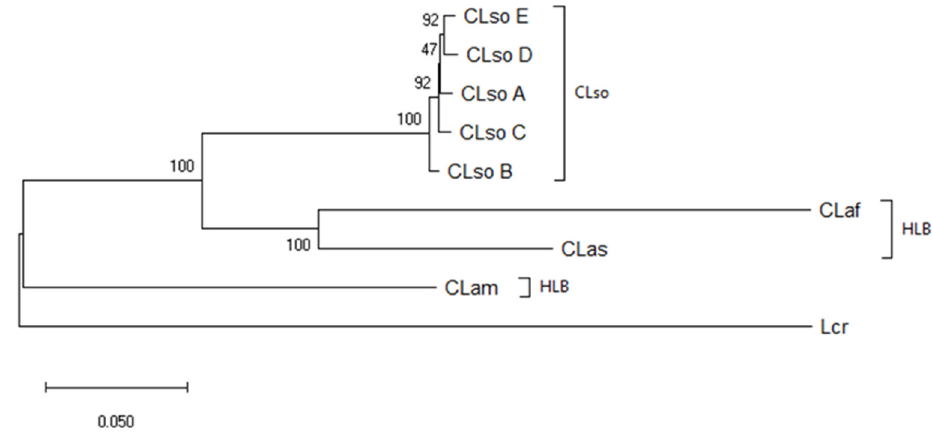
Figure 5. Phylogenetic tree of representative isolates of CLso, CLas, CLam, CLaf and Lcr based on concatenated sequences obtained from adk , dnaG , fumC , grpE , icdA , metG , mutS , purA , recA and gyrB . The evolutionary history was inferred using the Maximum Likelihood method and the Tamura-Nei model [28]. Bootstrap values (1000 replications) are shown at the branch points. A total of 3967 nt positions in the final dataset were analysed in MEGA X [27].